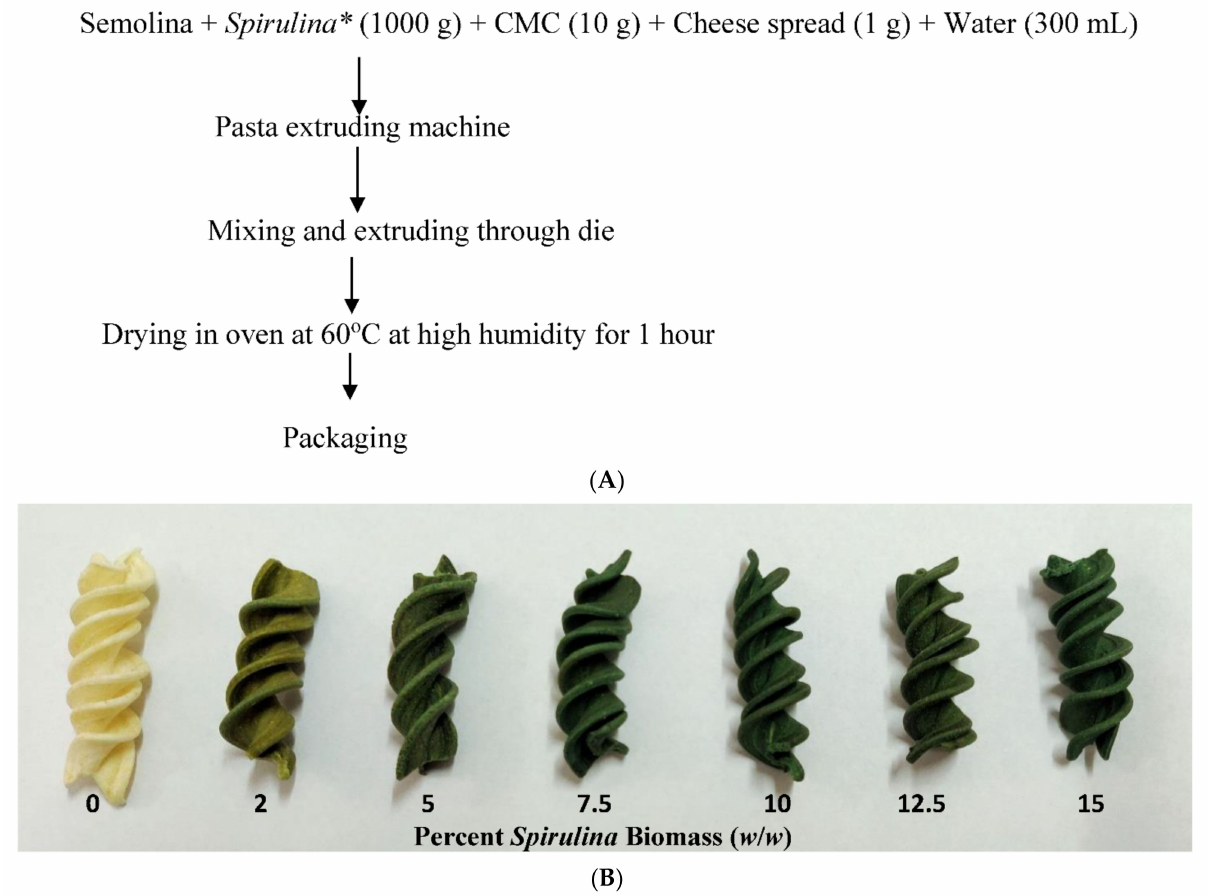
Figure 1. ( A ). Flow chart for preparation of Spirulina enriched pasta. * Spirulina addition shall vary with its percentage enrichment in total mixture. ( B ). Fusilli pasta (control and enriched green pasta with increasing order of Spirulina biomass) ( w/w ). Supplementation with edible blue green alga, Spirulina provided an appealing green tone that varied with Spirulina